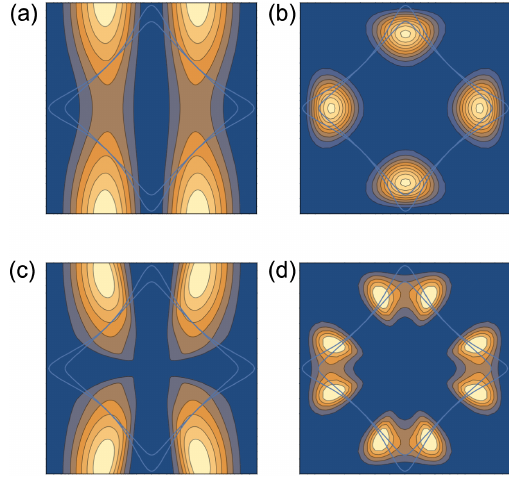
FIG. 12. Color maps of (a) v 2 x , (b) v 2 z , (c) v 2 x τ , and v 2 z τ in the Brillouin zone. The Fermi surfaces at k z ¼ 0 ; π are also shown. The lifetime τ is evaluated at T → 0 ; the data for (a),(c) and (b), (d) are evaluated for k z ¼ 0 and π = 2 , respectively.